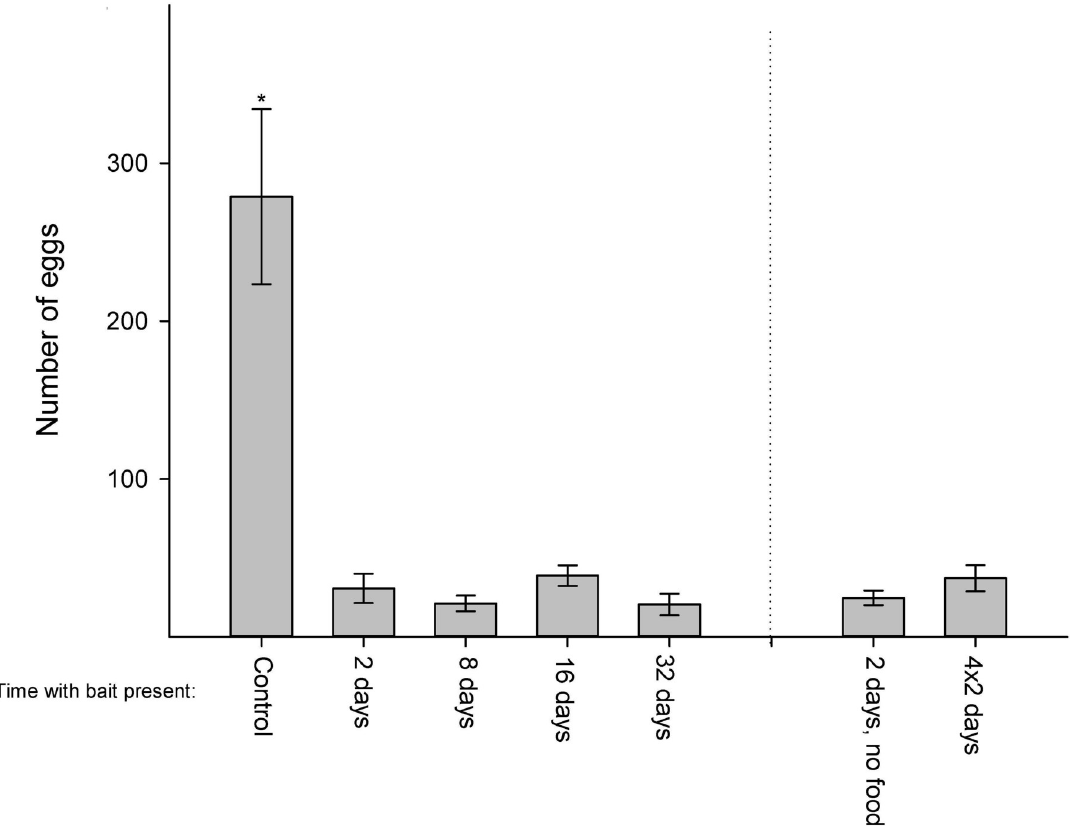
Fig 7. Egg deposition in treatments of different bait duration. � denotes significant difference to other treatments (Holm–Sidak, p <